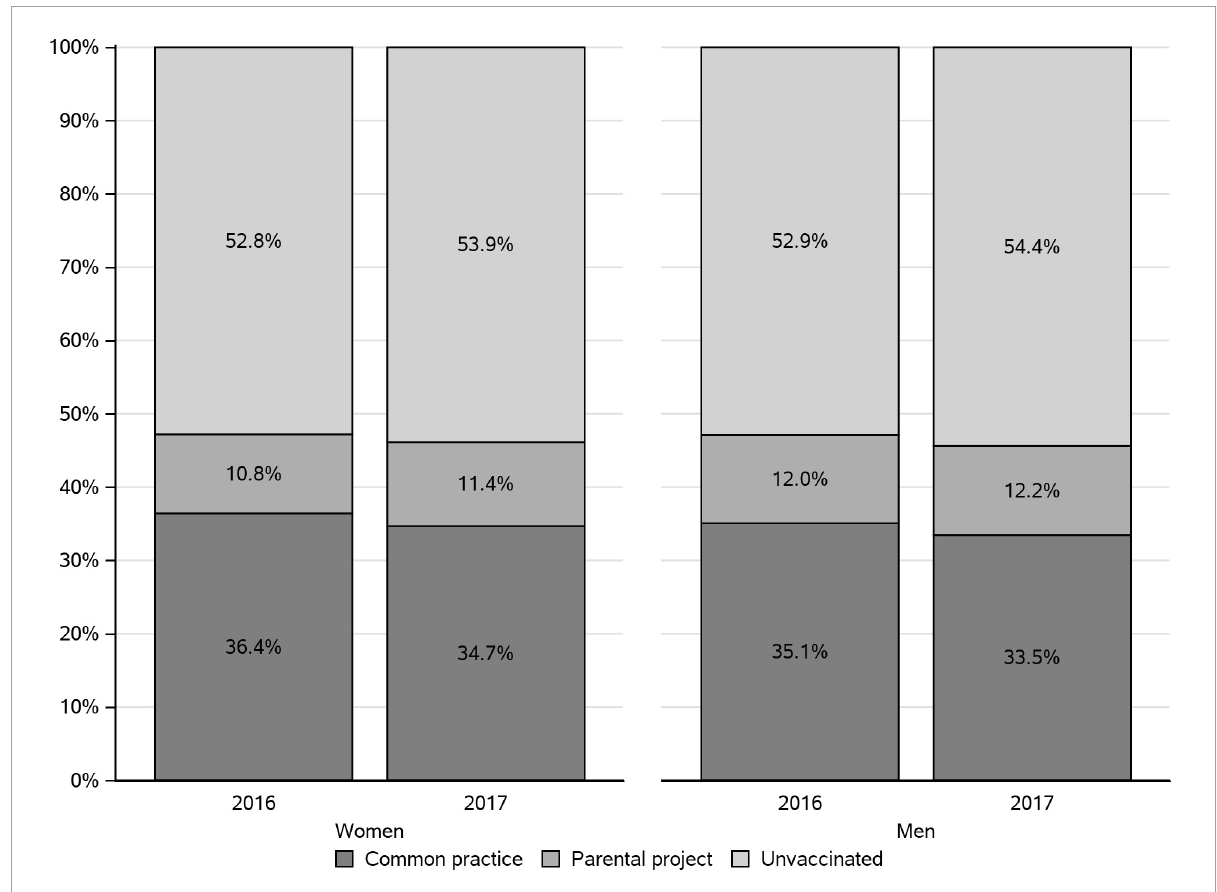
FIGURE2 Pertussis vaccination rate of women and men parents in 2016 and 2017, by period in which vaccine reimbursement was